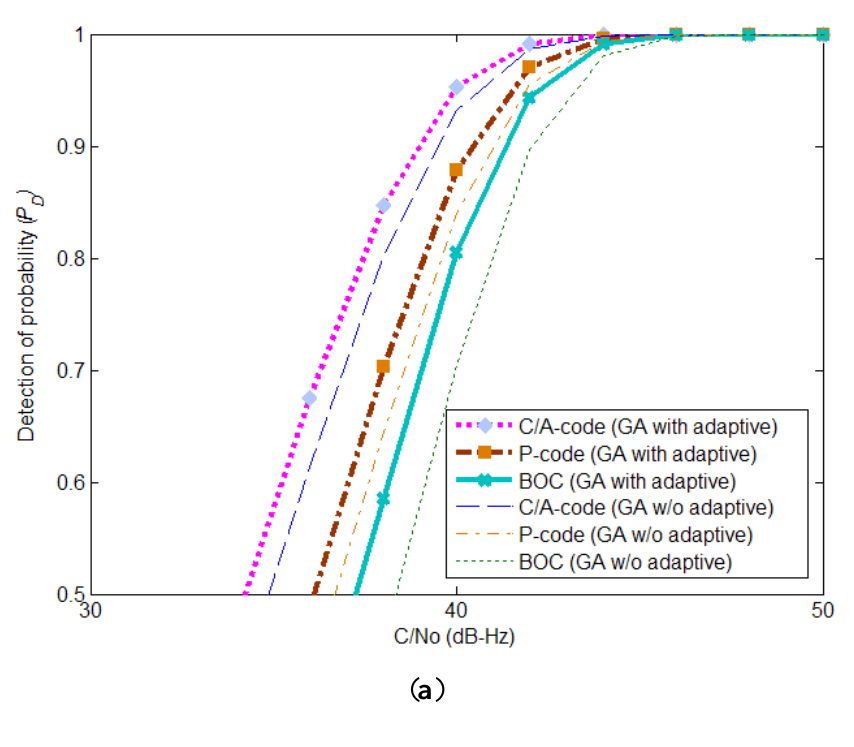
Figure 2. Performance of signal detection; ( a ) Probability of detection versus C/No for different acquisition methods ( ); ( b ) Probability of detection versus false alarm rate (C/No = 38